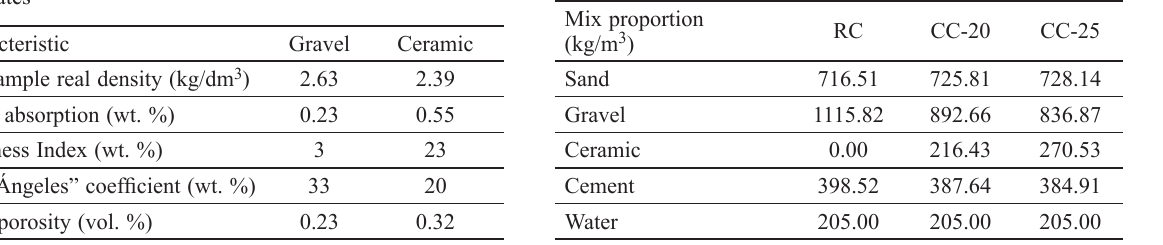
Table 2. Details of the concrete mixed used